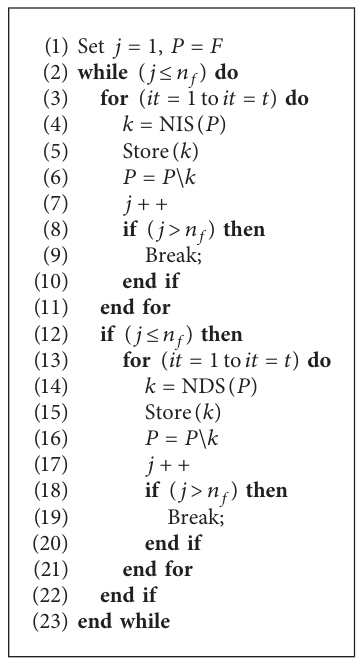
. A LGORITHM 4: t -swapping algorithm: SIDA t 2